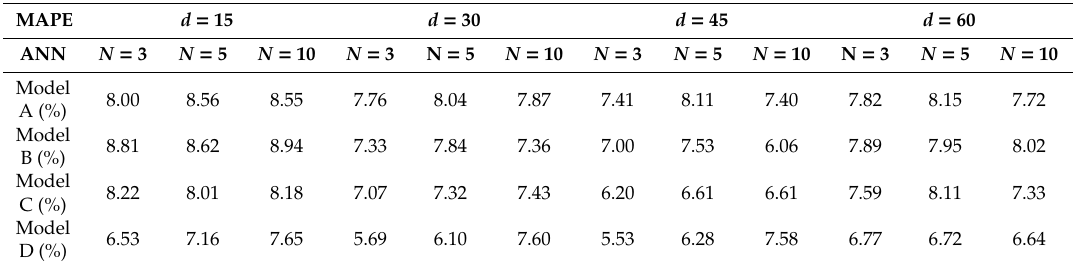
Table 5. Five-day average MAPE analysis (Artificial Neural networks).